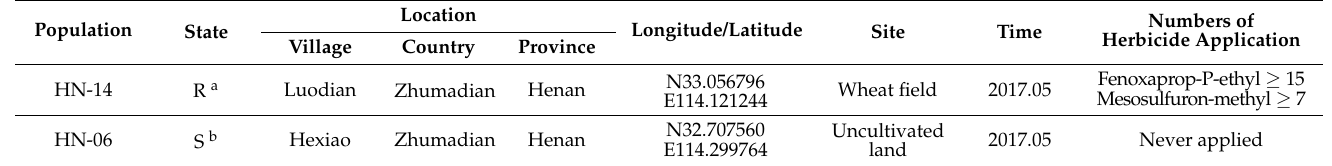
Table 1. Collection information and resistance of